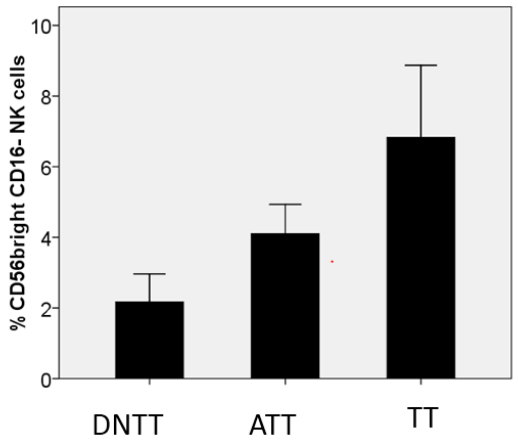
Figure 4. Changes in the percentage of CD56bright CD16 − NK cells with impaired cytotoxic activity in different areas of the tumor and “normal” adjacent tissues analyzed by flow cytometry. TT is enriched by CD56bright CD16 − NK cells, the percentage of which gradually increases from DNTT to TT. DNTT—distant non tumor tissue, ATT—adjacent tumor tissue, TT—tumor tissue. Tumor samples were obtained from primary lung tumors of non-treated patients by excision of a tumor mass fragment. ATT samples were taken from tumor-adjacent lung tissue located at approximately 1 cm from the periphery of the tumor without macroscopic signs of a tumor. DNTT and ATT samples were thoroughly analyzed to guarantee the complete absence of epithelial tumor cells. The NK cell subset was determined by the selection of CD45+ CD3 − CD20 − cells in the FSC low /SSC low gate and calculated as a percentage of all NK cells